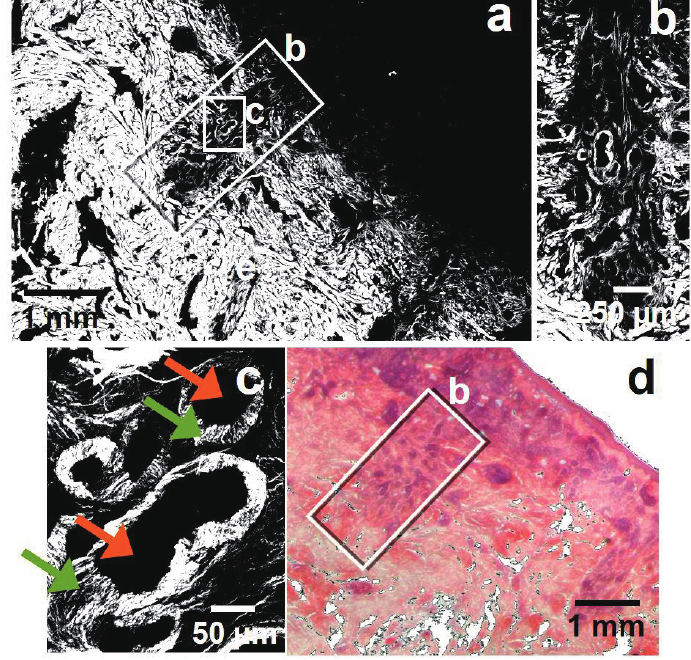
Figure A1. SHG images of an invasively growing BCC with peculiar collagen fiber orientation. ( a ) Overview scan of the BCC; ( b ) Infiltrate growing area; ( c ) Tumor nests. The orange arrows point at the BCC tumor nests lacking any SHG. The green arrows point to positions with collagen fibers, which are directed dominantly perpendicular to the tumor nest surface; ( d ) H&E stained parallel section with marked tumorous